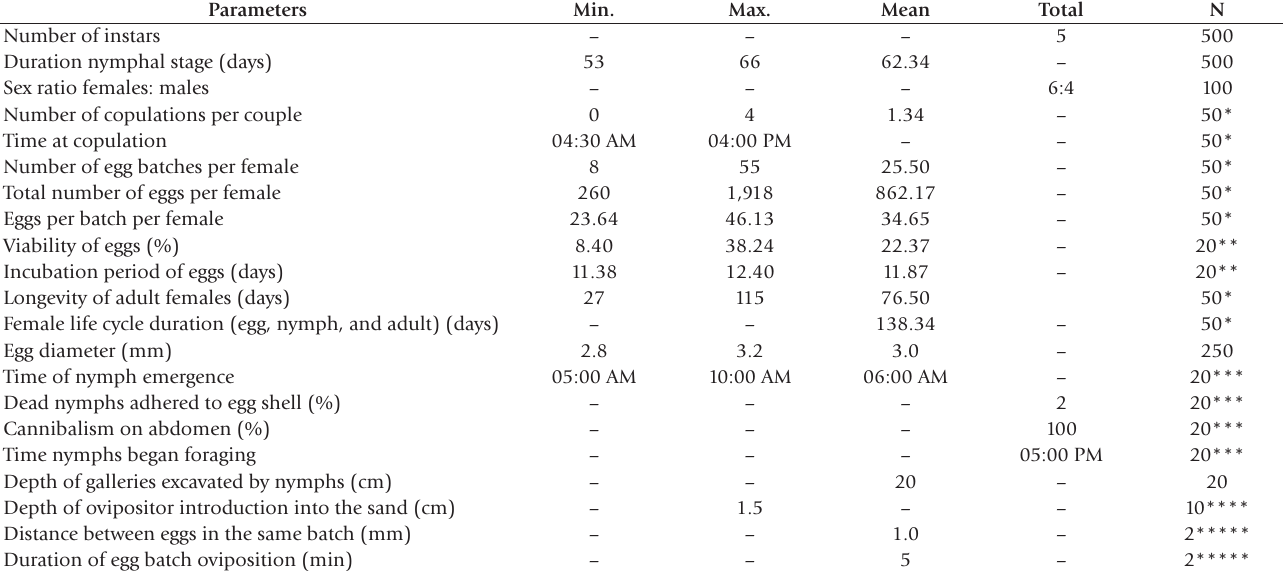
Table 1. Gryllus assimilis biological and behavioral parameters under laboratory conditions: minimum (Min.), maximum (Max.), mean (Mean), total (Total), and sample size